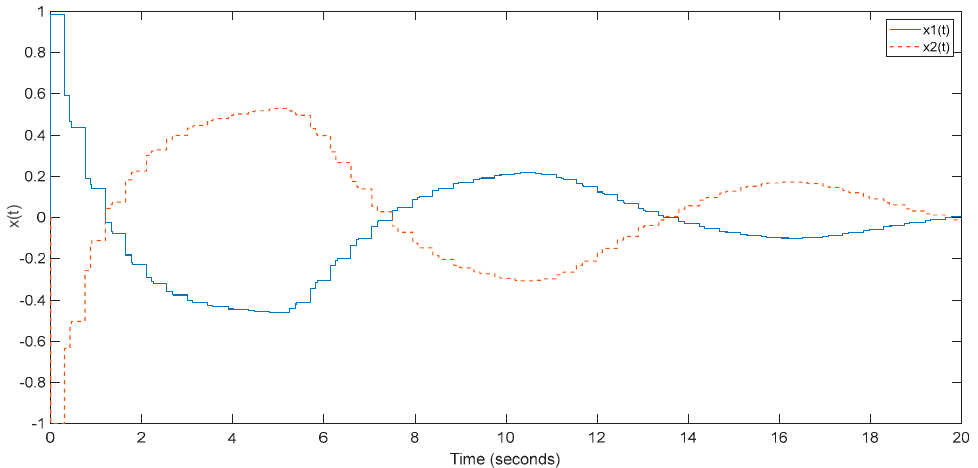
Figure 6. Sampled ‐ data state for synchronous signal in (19) and input in (20) with zero disturbance input.